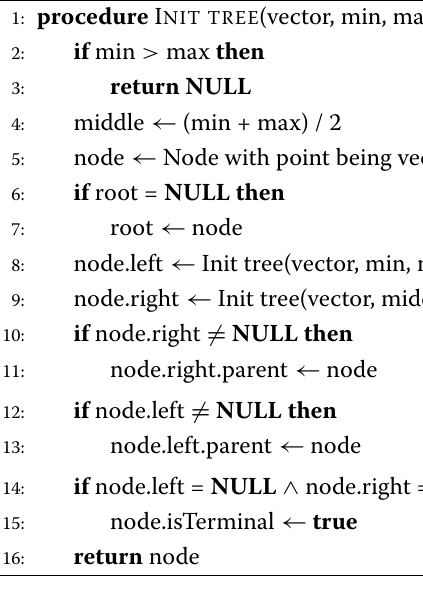
Algorithm 1 Initialisation of Neural N-Tree